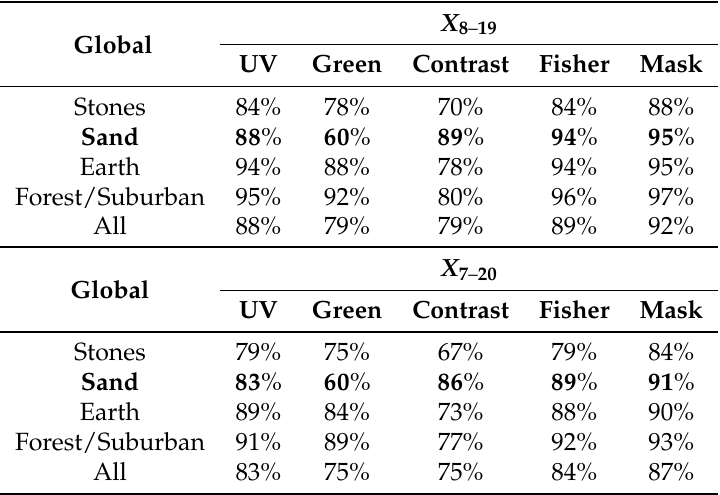
Table 1. The classification rates of the global separators introduced in Section 2.3—the linear separators w UV (UV-only), w G (green-only), w con (contrast: 1:1), w F (contrast: Fisher discriminant) and the binary masks (non-linear UV/G separator)—applied to the datasets shown in Figures 9 and 10. The separation methods were trained and tested on two different samples (each containing 10 5 elements of the sky and ground class) drawn from the specified databases. An evaluation using single HDR image pairs (e.g., as captured by a mobile robot) as test data instead can be found in Figure 11. Only for sand (highlighted), the classification rates show a noticeably increased performance for the UV/G contrast (Fisher discriminant) compared to UV-only separation. In all other cases, both methods show a similar performance, both slightly worse compared to the best possible performance of the binary masks. Classification rates obtained by applying the learned global separation techniques to the input HDR images (UV and green) directly can be found in Figure 11.